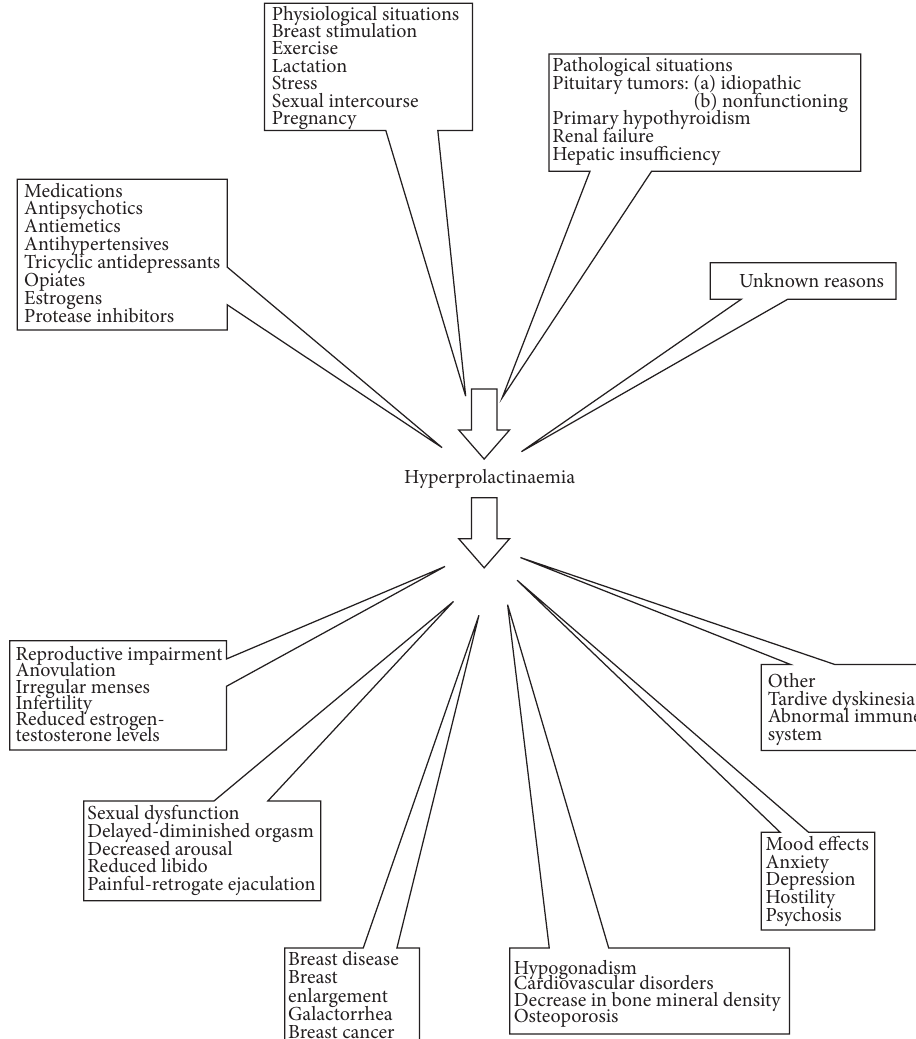
Figure 1: Reasons for hyperprolactinaemia and its side